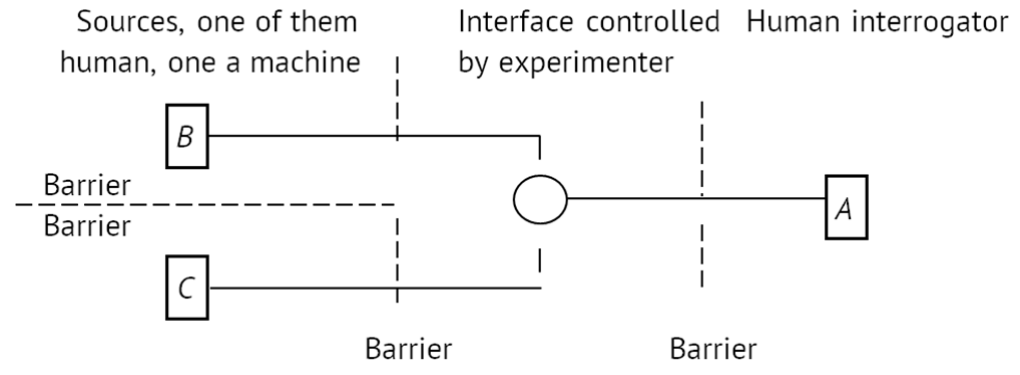
Figure 2. A diagram of Turing's test.